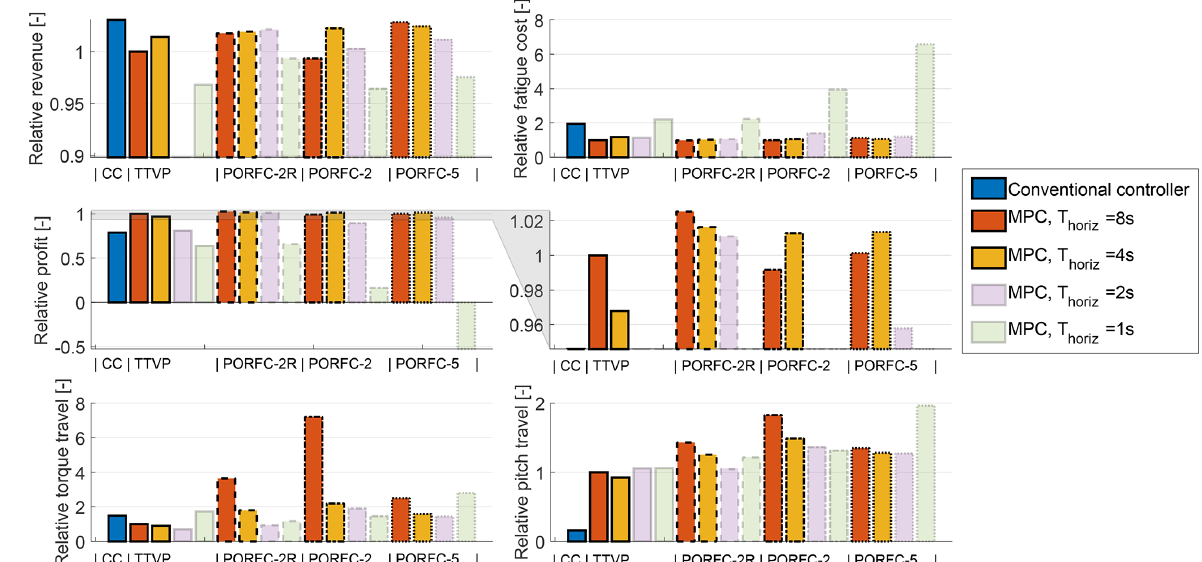
Figure 11. “Default lidar” scenario. Weibull-weighted KPIs for different controller formulations (indicated by edge style) and MPC predic- tion horizon lengths (indicated by color). The results for the shorter horizons are transparent in order to focus the attention on the more im- portant longer horizons. Results are normalized with respect to the best TTVP configuration with a prediction horizon length of T horiz = 8s. Middle row, right: zoomed version of profit plot.